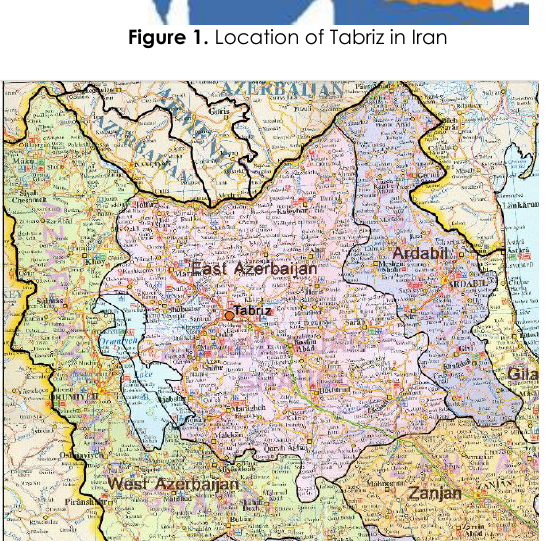
Figure 2. Location of Tabriz in East Azerbaijan Province (UNESCO, 2009).